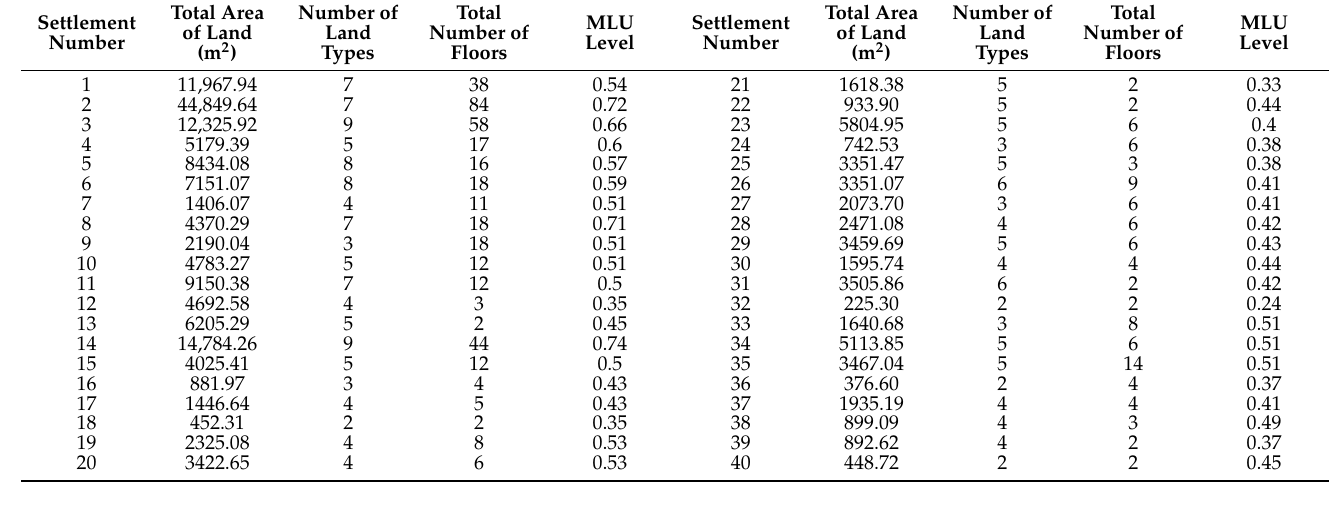
Table 6. Level of MLU for rural settlements in the study area in 2021.